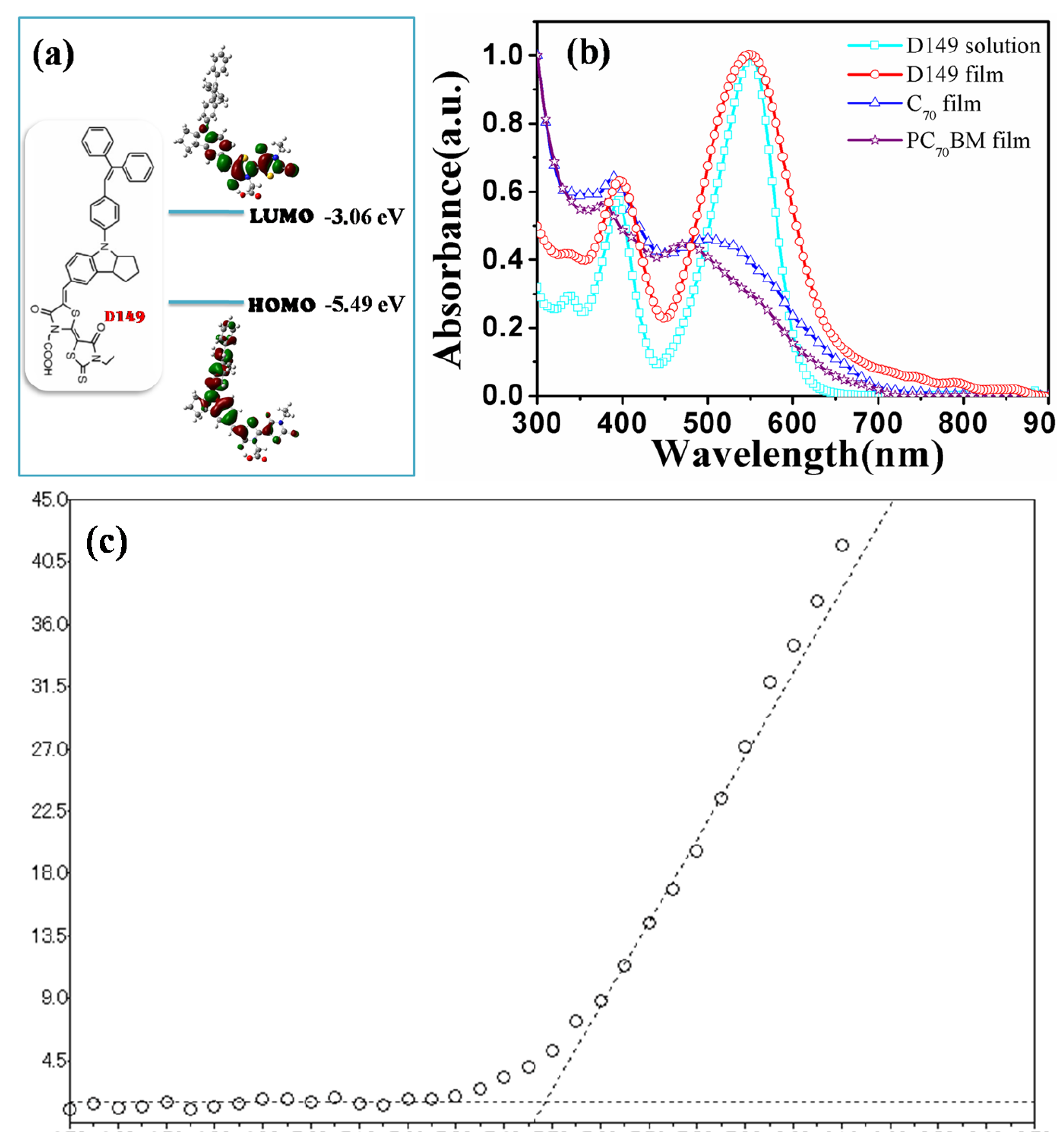
Figure 1. ( a ) Molecular structure and molecular orbitals of D149; ( b ) Normalized Absorption spectra of D149 in solid film and solution, and C ( c ) The HOMO level of D149 measured by AC-3 was − 5.49